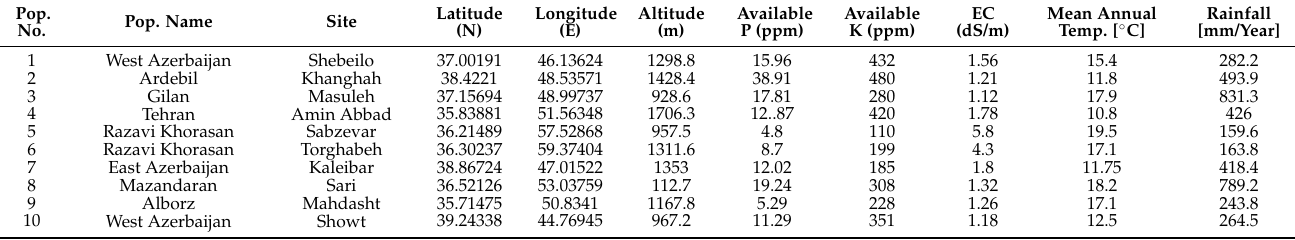
Figure 5. Sample collection sites located in different provinces of Iran. Numbers showing the collection sites. Table 5. Origins, geographical characteristics, and soil properties of studied H. persicum populations.